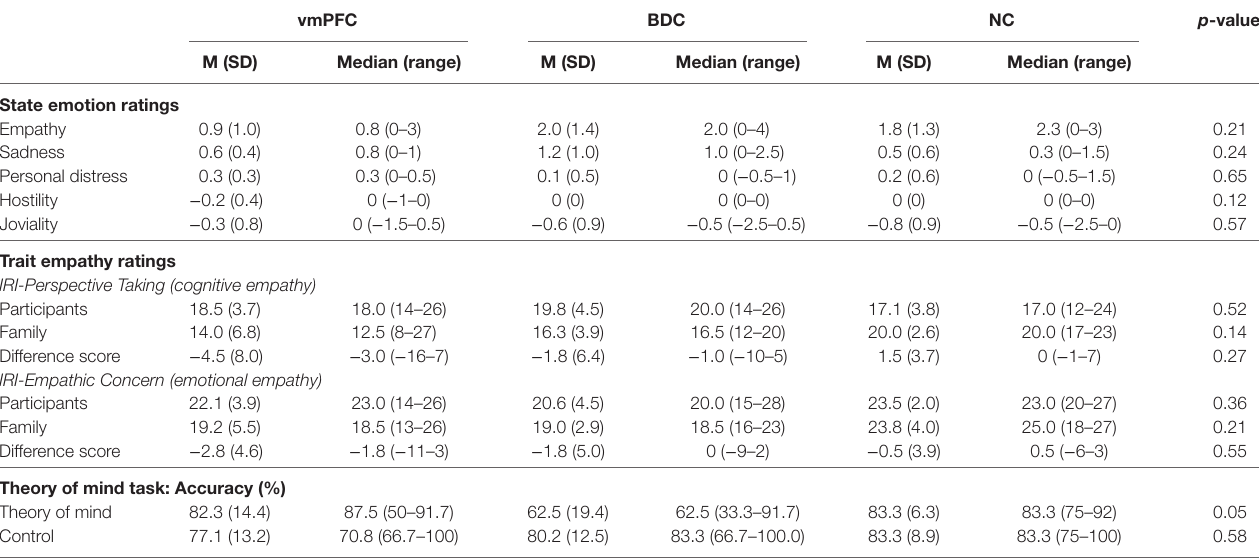
TaBle 3 | Assessments of state emotion, empathy, and theory of